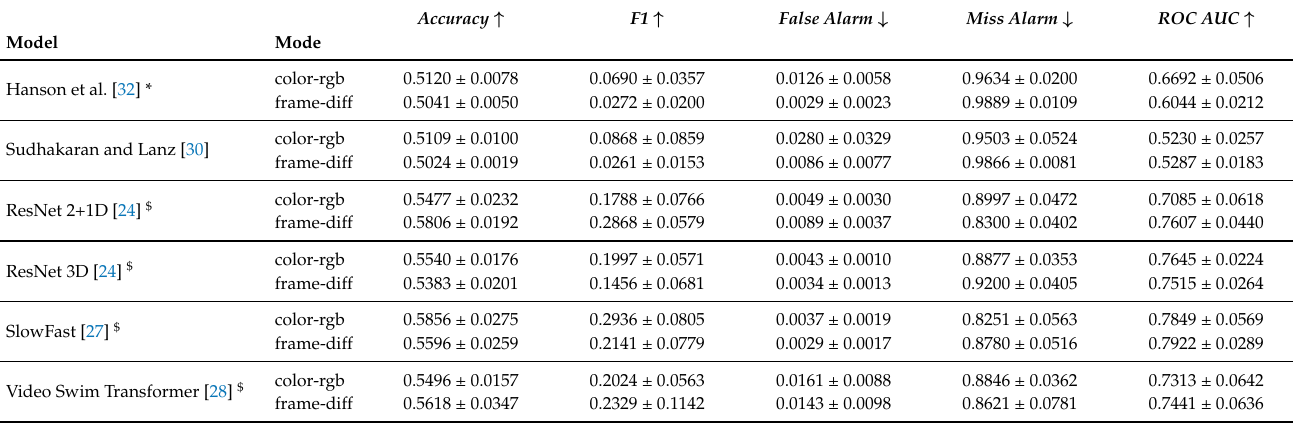
Table 5. Cross-dataset evaluation (pre-training on RWF-2000 [22] dataset, test on our Bus Violence